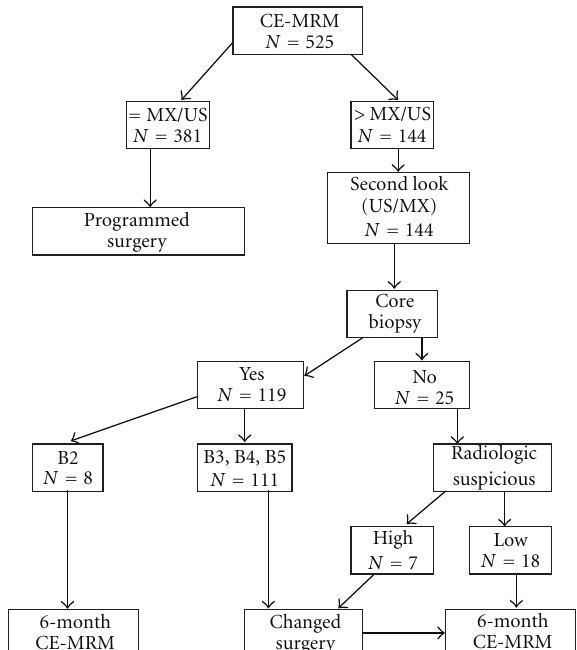
Figure 1: Additional evaluation based on breast CE-MRM findings and change in preoperative management. = MX/US: CE-MRM report in concordance with MX/US. > MX/US: CE-MRM detects more or larger lesions. B2: benign lesion; B3: lesion of uncertain malignant potential; B4: suspiciousnes of malignancy; B5: malig- nant (B5a: in situ carcinoma (DCIS) or B5b: invasive carcinoma) [14, 15]. N : number of